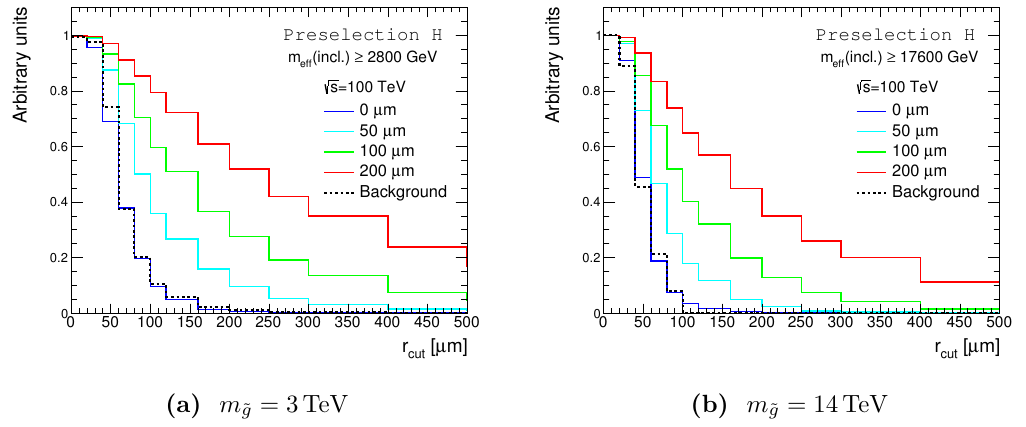
Figure 19. Fractions of events which pass the selection cut j r di(cid:11)erent values of c(cid:28) ~ g , shown in the solid lines. The distributions for the SM background events are also shown in the dotted lines. We have imposed preselection-H , and m e(cid:11) (incl : ) > 2800 GeV (17600 GeV) in (cid:12)gure 19a ((cid:12)gure